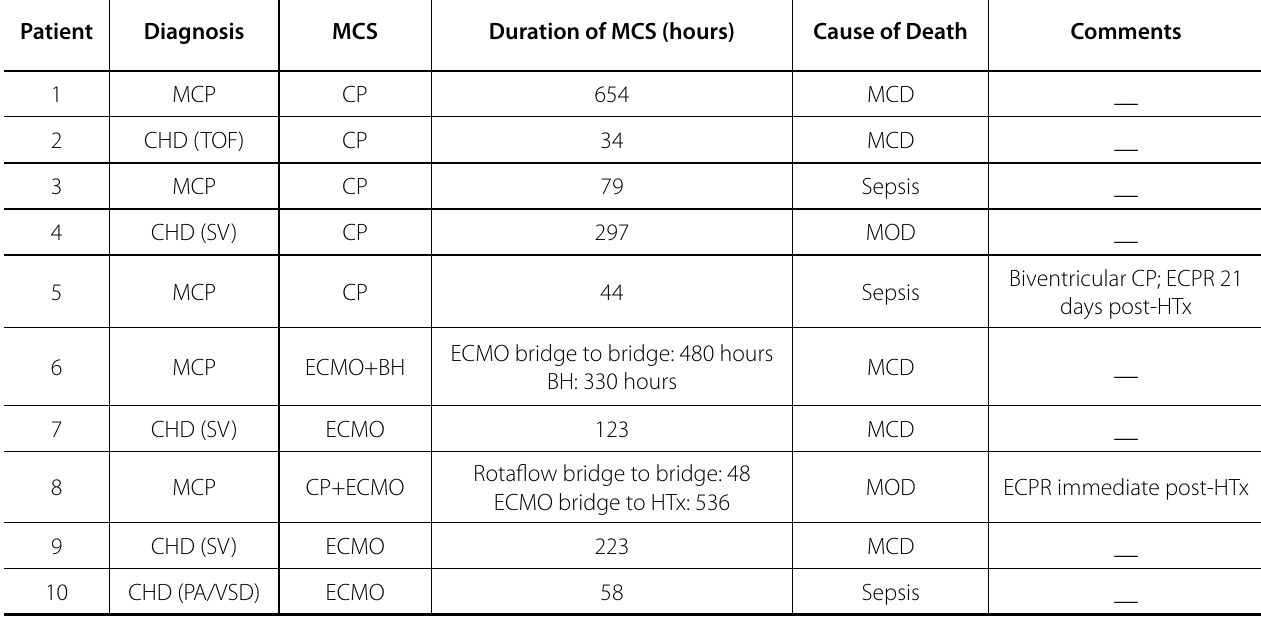
Table 3. Causes of death after heart